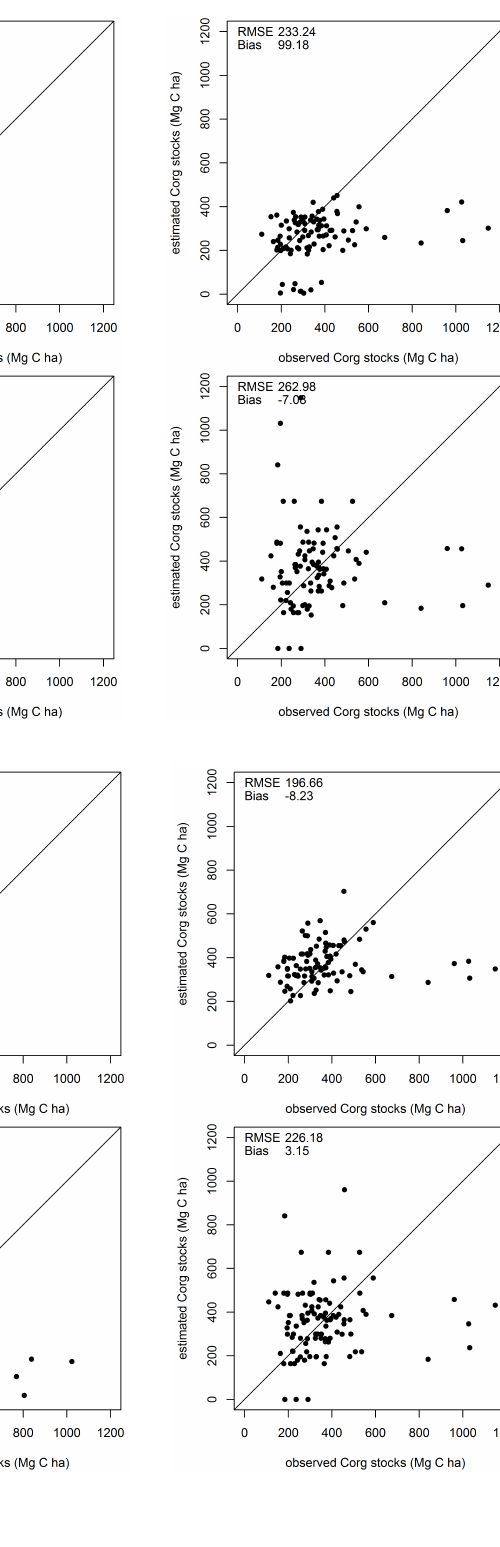
Figure 5. ( a ) Scatterplots of kNN (above) and SOM (below) estimated and observed survey plots for C stocks in vegetation (left), soil (central) and total (right) based on org RapidEye only; ( b ) Scatterplots of kNN (above) and SOM (below) estimated and observed survey plots for C stocks in vegetation (left), soil (central) and total (right) based on org RapidEye and additional